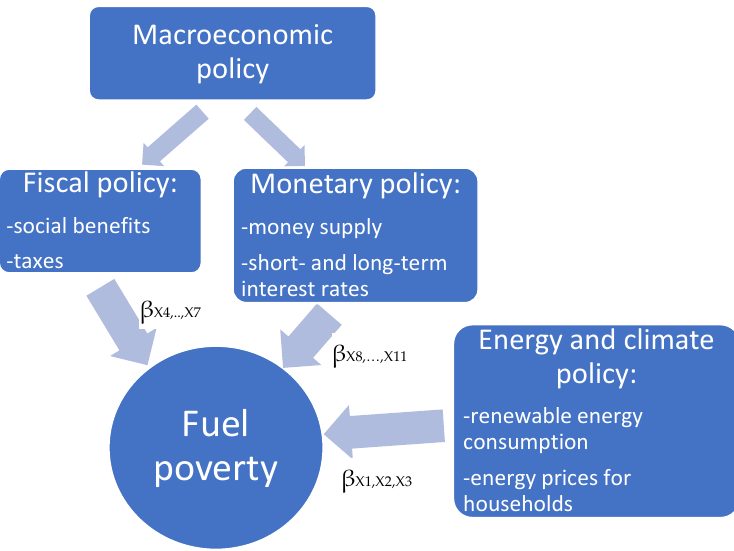
Figure 1. Model for analysing the impact of macroeconomic policy on fuel poverty.